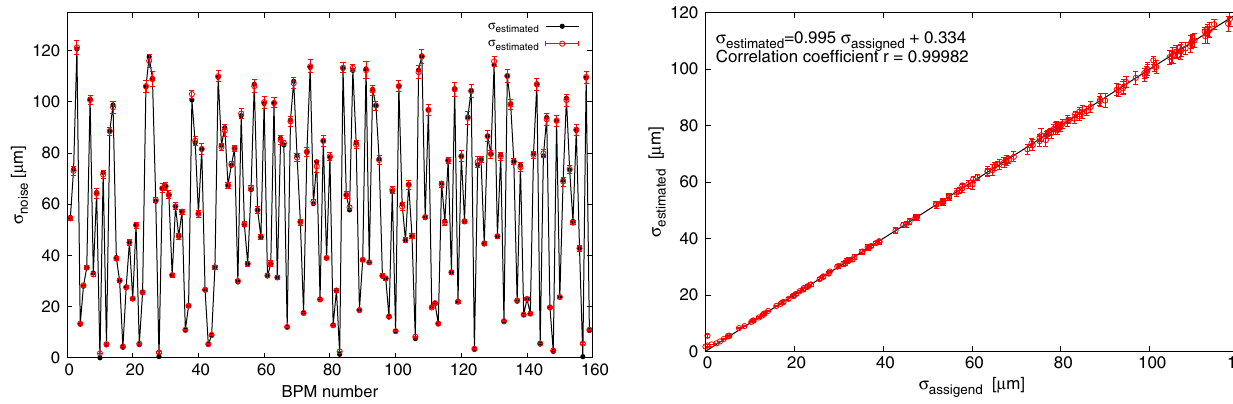
FIG. 2. Left: Assigned and estimated standard deviations of noise at different BPMs. Error bars reflect the standard deviation of ten estimations in which each estimation was against TBT BPM data with noise generated by a unique random seed. Right: Estimated versus assigned standard deviations of BPM noise.